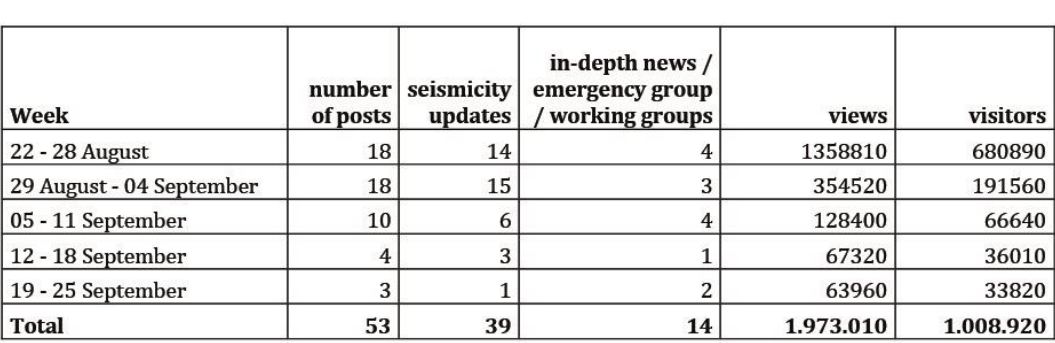
Table 1 : The number of posts, weekly views (visite) and visitors (visitatori) of the INGVterremoti blog, during 5 weeks, from August 22, 2016 to September 25, 2016.